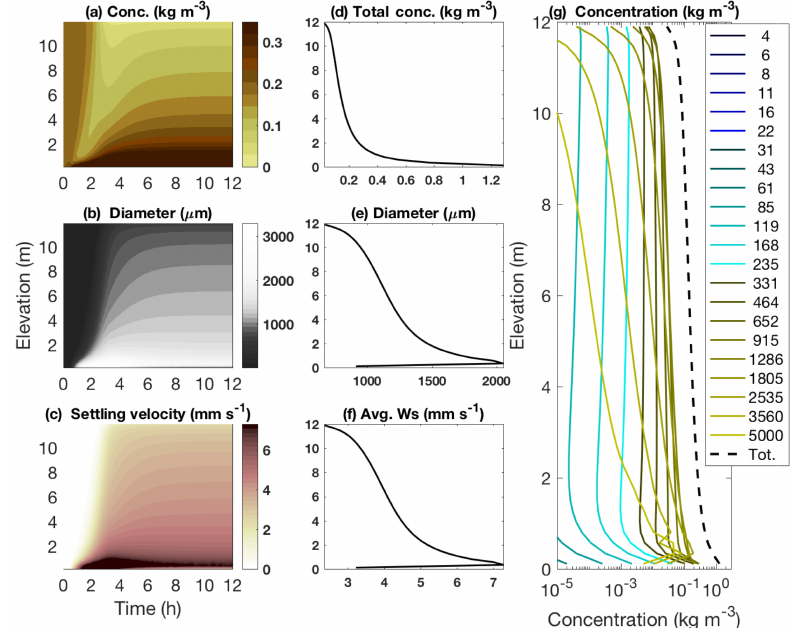
Figure 4. Simulation of steady open-channel flow initialized with a vertically uniform concentration of 0.2kgm − 3 in the 8µm class. Tem- poral evolution of profiles of (a) mass concentration, (b) mass-weighted diameter, and (c) mass-weighted settling velocity. Final profiles of (d) concentration, (e) diameter, and (f) settling velocity, and (g) final concentration profiles for each class size (colored lines) and the sum of all classes (dashed